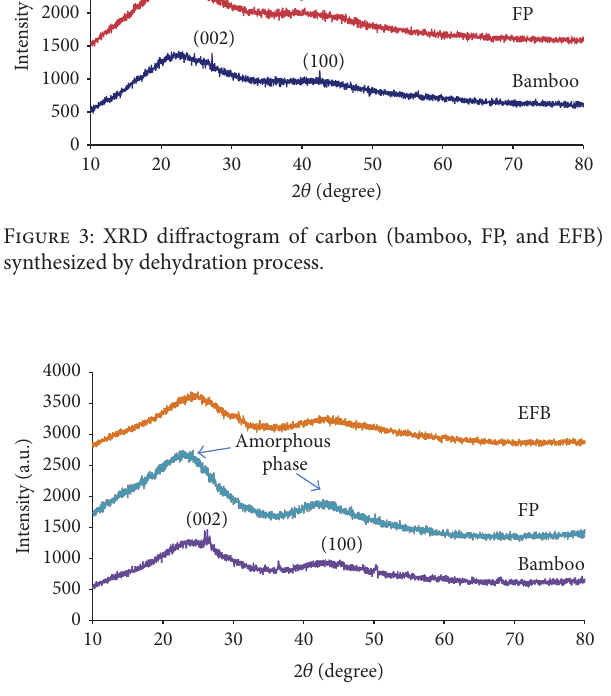
F 4: XRD diffractogram of carbon (bamboo, FP, and EFB) synthesized by carbonization